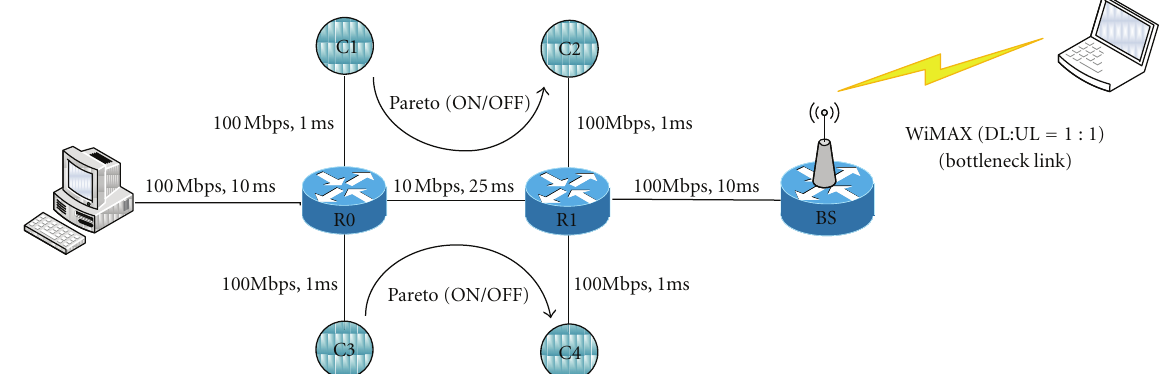
Figure 5: Variation of congestion window versus time (PER = 0.001).